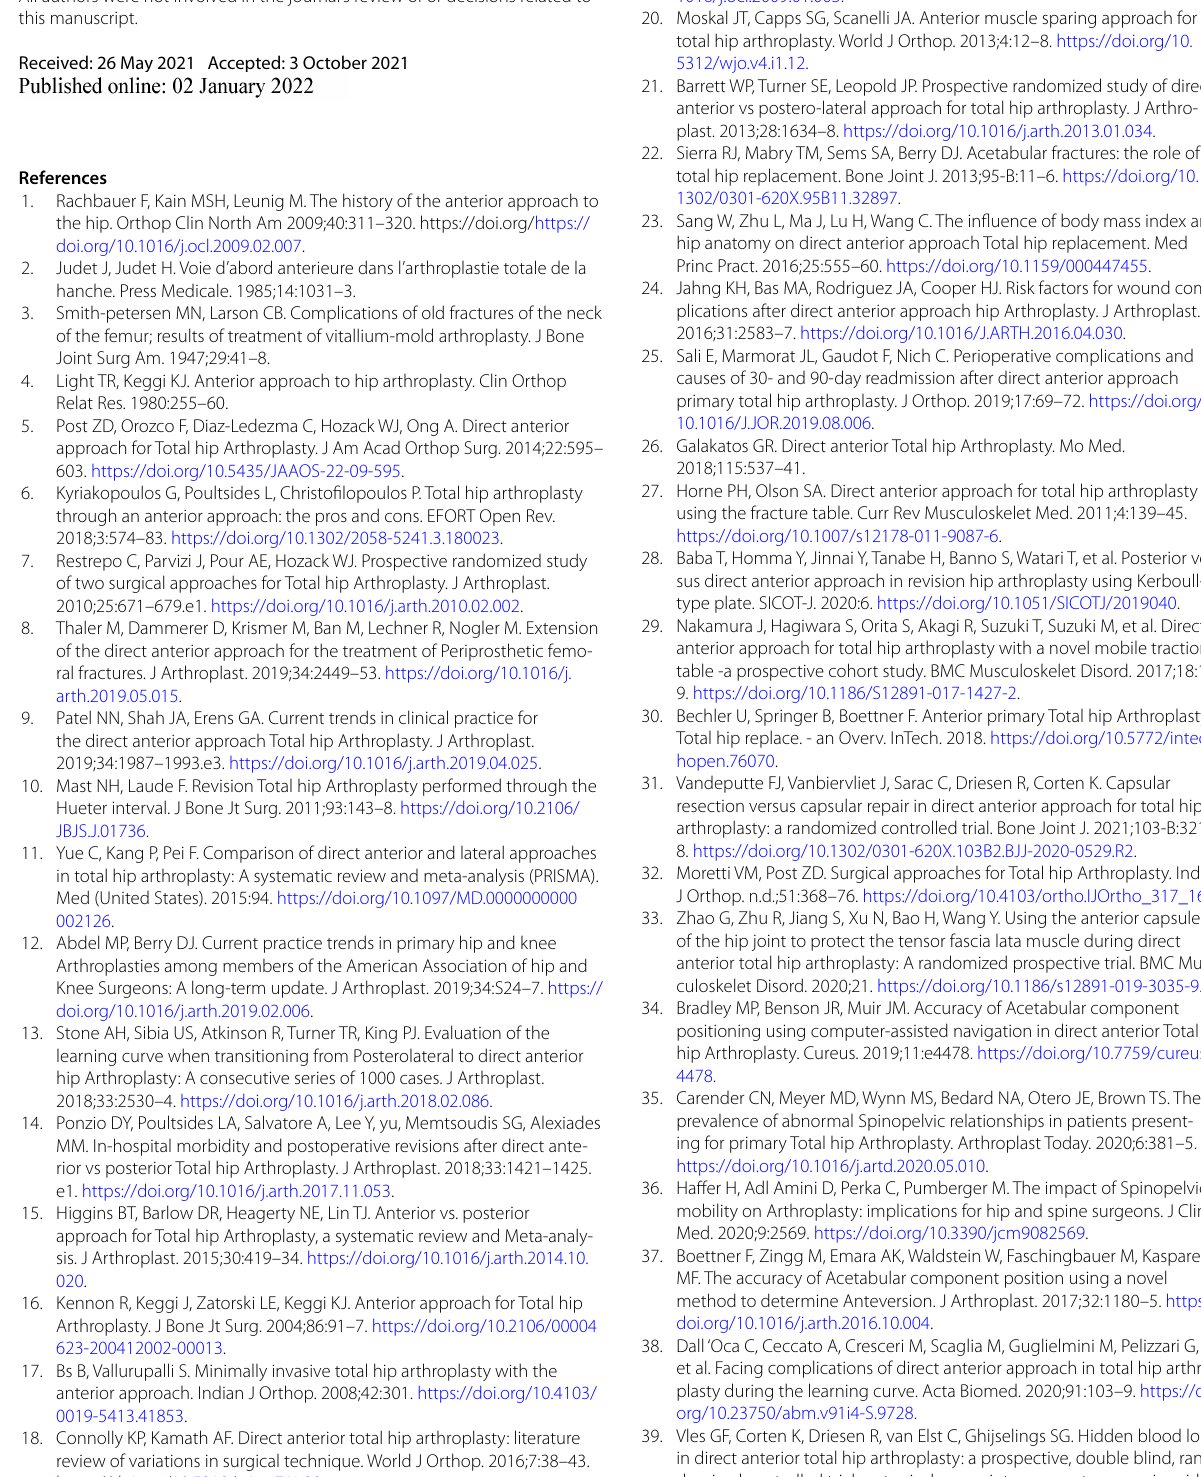
J Orthop. n.d.;51:368–76. https:// doi. org/ 10. 4103/ ortho. IJOrt ho_ 317_ 16. 33. Zhao G, Zhu R, Jiang S, Xu N, Bao H, Wang Y. Using the anterior